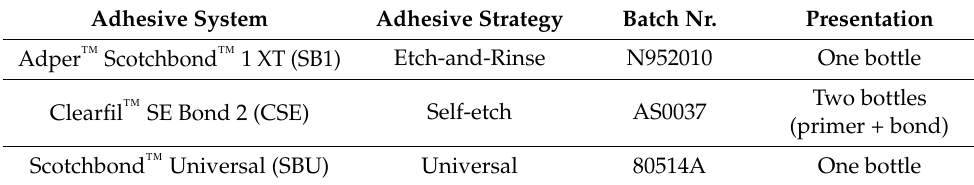
Table 2. Adhesive systems at study, the adhesive strategy, batch number, and presentation. Adhesive System Adhesive Strategy Batch Nr.